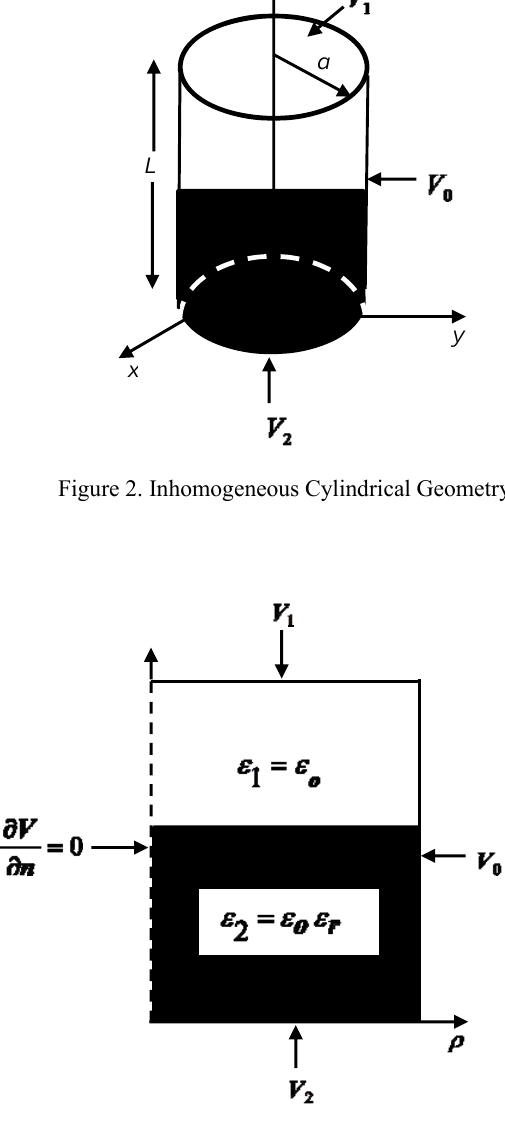
Figure 3. Inhomogeneous Axisymmetric Solution Region